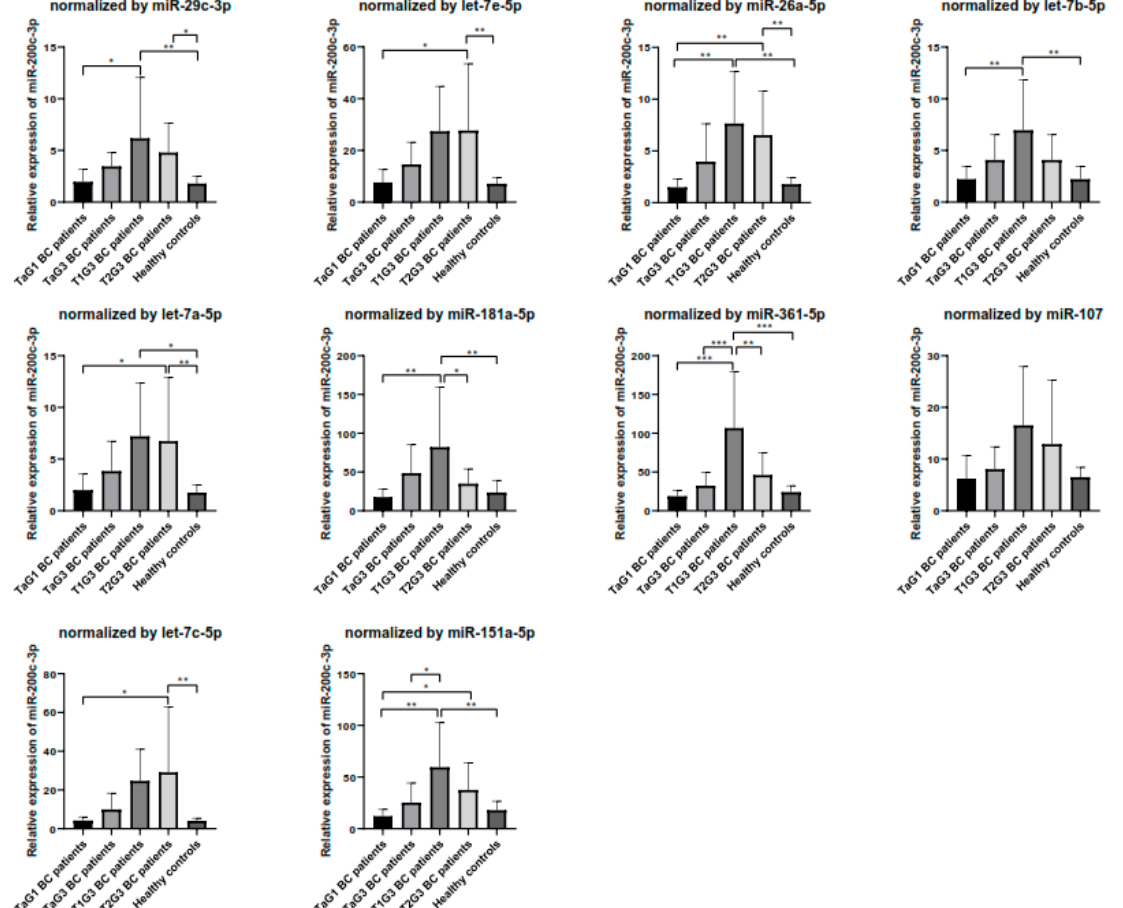
Figure 6. Relative expression of miR-200c-3p normalized by each candidate miRNA selected by the comprehensive ranking of RefFinder. Normalization was performed by the 2 − ∆∆ Ct method. Error bars represent the standard error of the mean. ANOVA with the Tuckey Post Hoc test: * p < 0.05; ** p < 0.01; *** p < 0.001.